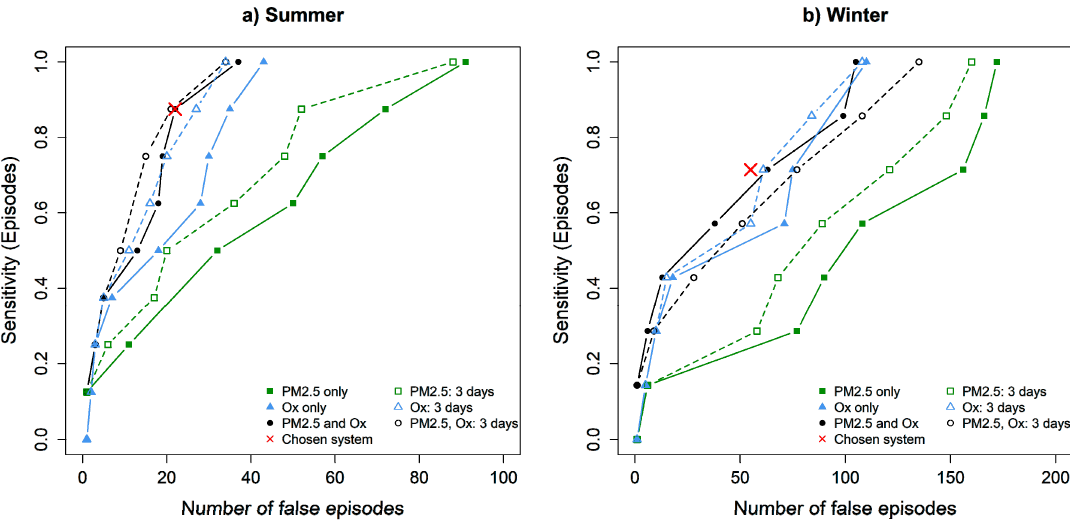
Figure 4. Receiver operating characteristic (ROC) curves for different variables used in the air pollution-health warning system (APHWS). For a type of APHWS, each point corresponds to the result of a particular weighting and threshold couple. The points reported here correspond to likely choices, i.e., to the best trade-offs between sensitivity and false alarms. Filled symbols correspond to APHWS with two-day indicators, and empty symbols to APHWS with three-day indicators. The red cross corresponds to the system of Table 3.